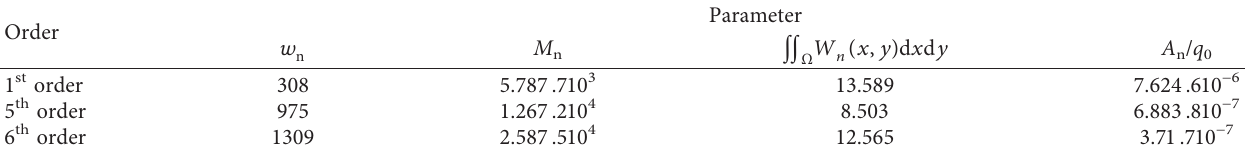
Table 5: The effective vibration modes of the thin plate rock mass under impact load (C-C-C-C).